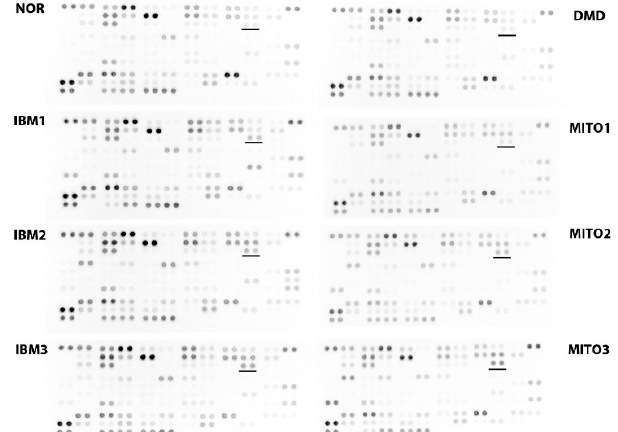
Figure 3. Serum growth differentiation factor 15 (GDF-15) levels in patients with sporadic inclusion body myositis. The Human XL Cytokine Proteome Profiler Array (Bio-Techne, Abingdon, UK) visualizes double spots representing GDF-15 levels in serum (underlined). NOR: Normal commercial control sample (Sigma, Overijse, Belgium); IBM1–3: Patients diagnosed with sporadic inclusion body myositis—IBM1 (female of 70 years); IBM2 (male of 72 years); and IBM3 (male of 67 years); DMD: Patient with Duchenne muscular dystrophy due to DYS